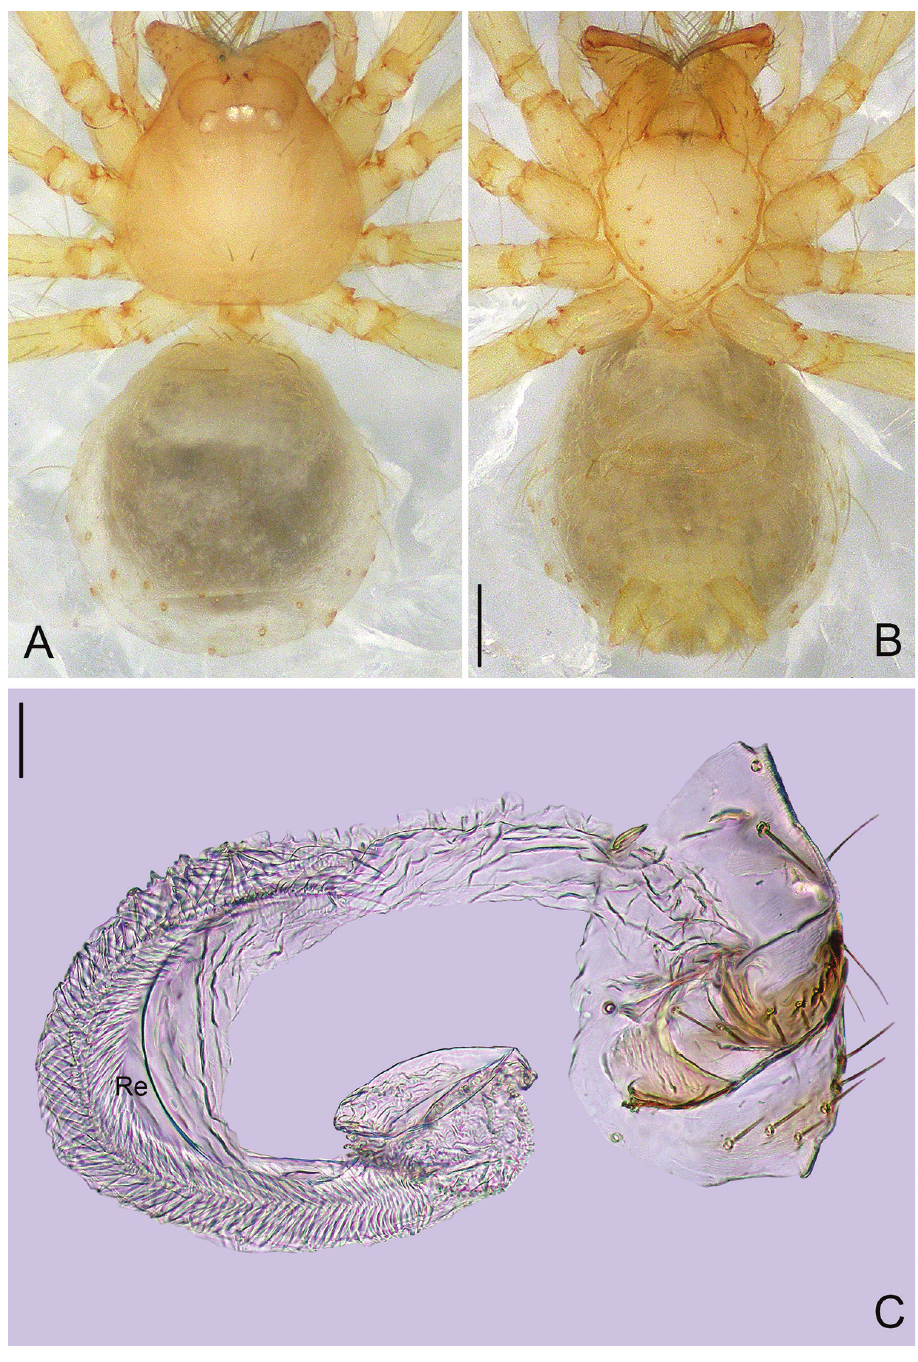
Figure 4. Pinelema podiensis sp. n., female paratype. A Habitus, dorsal view B Habitus, ventral view C Vulva, lateral view. Scale bars: 0.2 mm ( A–B ), 0.05 mm ( C